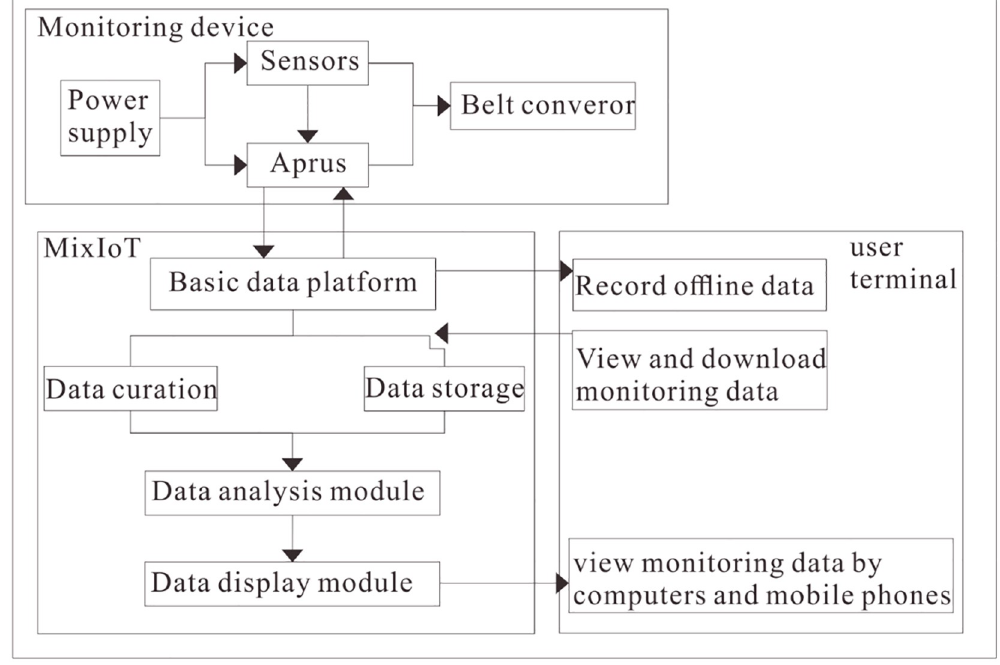
Fig 3. The framework for system design and